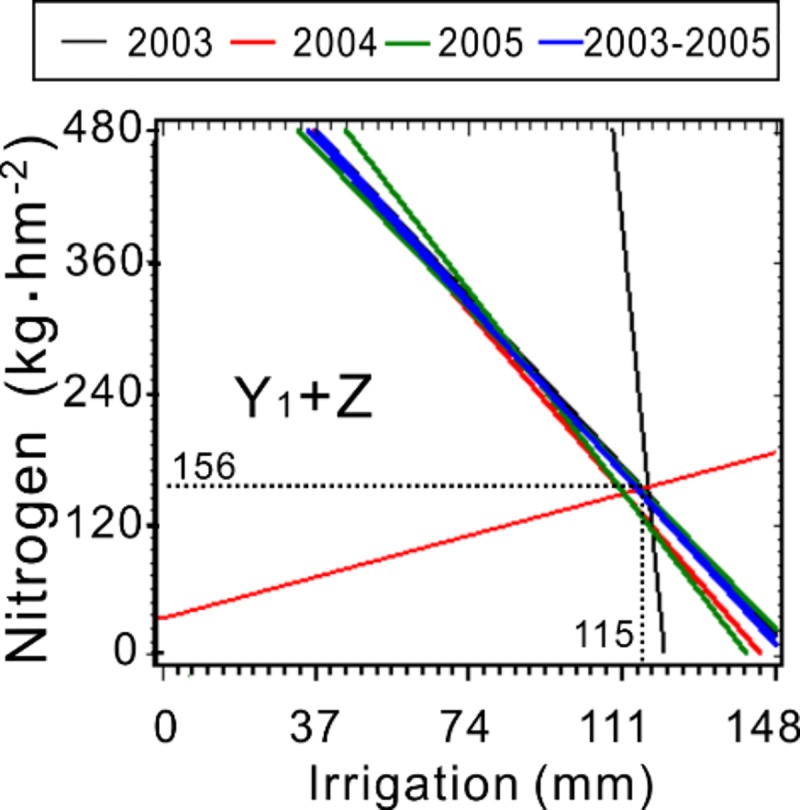
Ridgelines of the seed yield and seed yield component models.